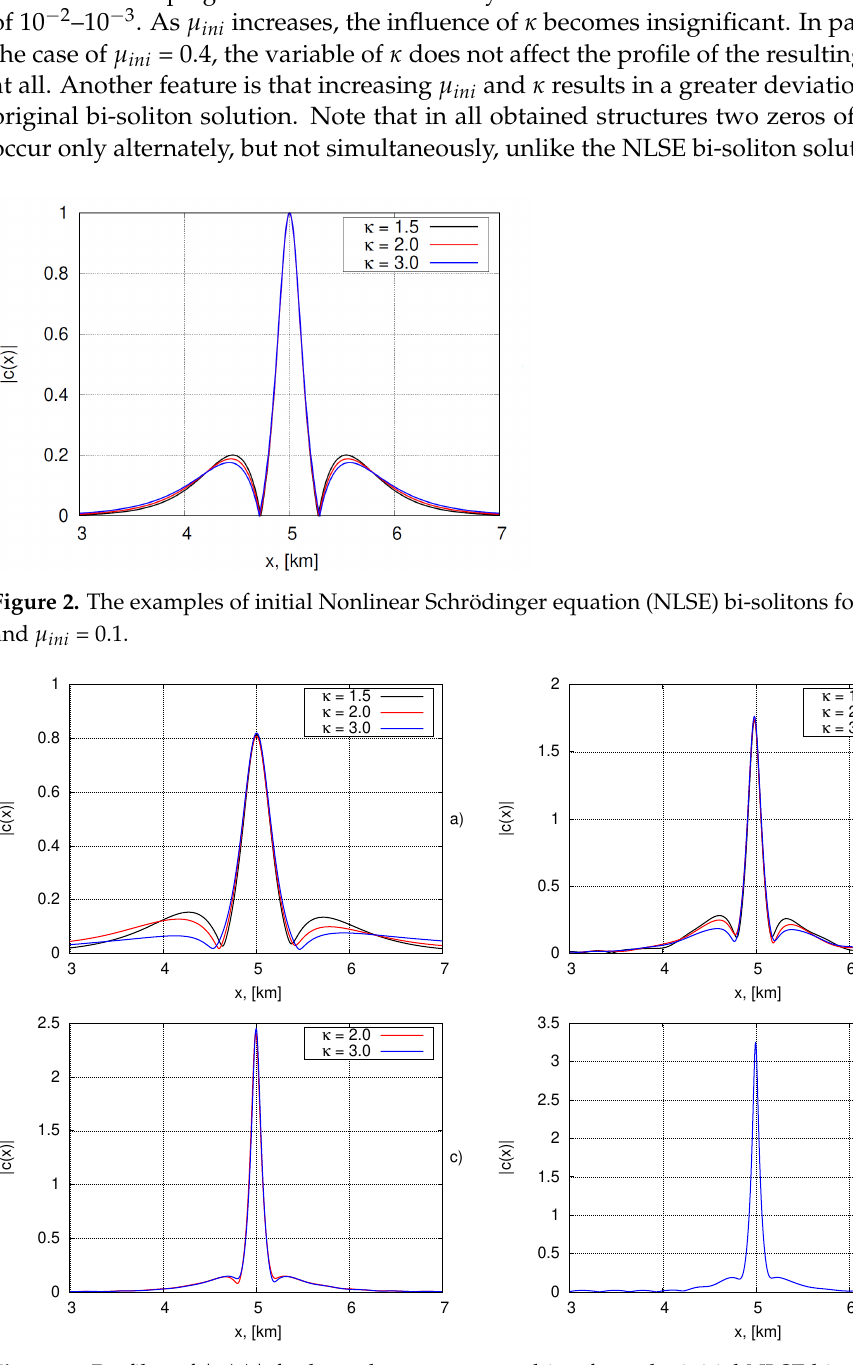
Figure 3. Profiles of |c(x)| for bound structures resulting from the initial NLSE bi-solitons with different κ and µ ini = 0.1 ( a ), 0.2 ( b ), 0.3 ( c ) and 0.4 ( d ). As µ ini increases, the influence of κ becomes